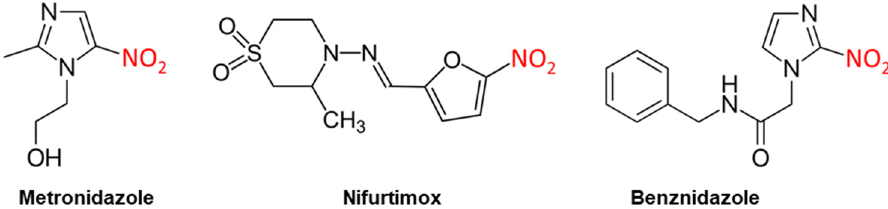
Figure 2. Nitro-drugs are a mainstay of antiprotozoal chemotherapy. The 5-nitroimidazole metron- idazole is used for intestinal pathogens and trichomoniasis; the 2-nitroimidazole benznidazole for Chagas disease; the nitrofuran nifurtimox for Chagas and, in combination with eflornithine, for gambiense HAT.